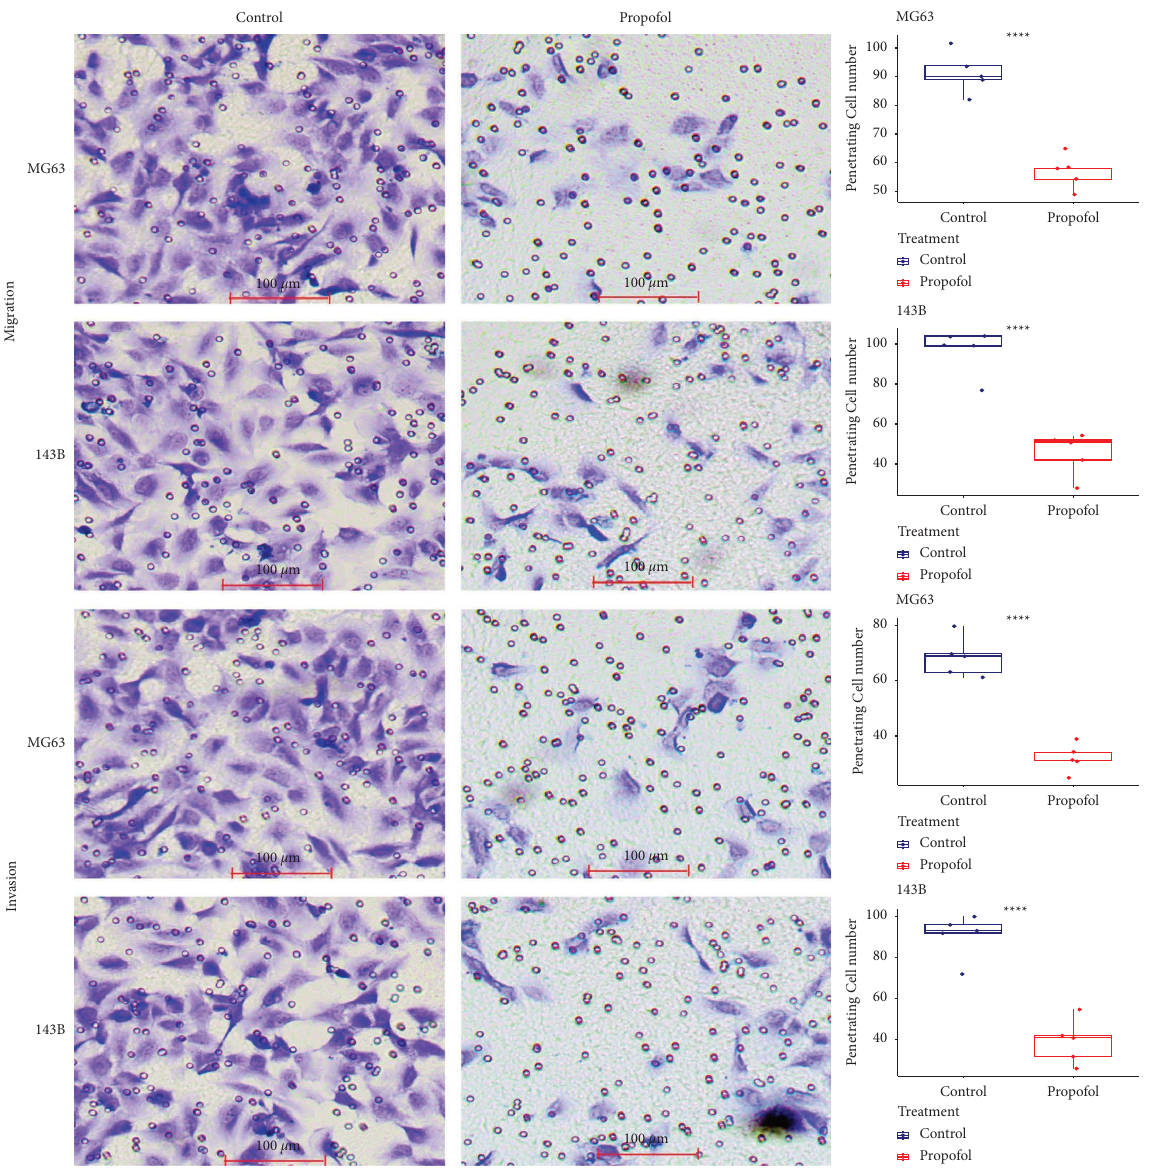
Figure 2: Propofol treatment led to decreased cell migration and invasion in MG63 and 143B cells. Each experiment was conducted with 5 biological